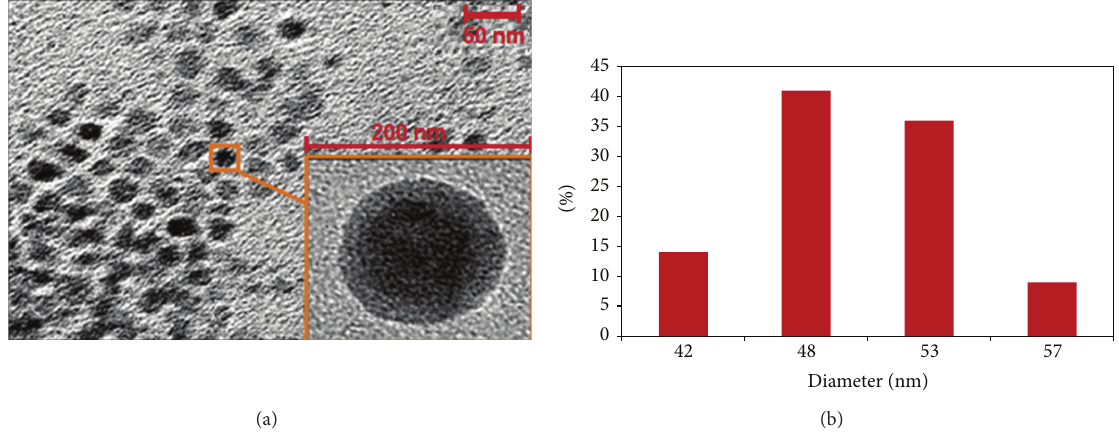
Figure 1: (a) TEM images of freshly prepared BCP; inset is TEM image of an individual Cu/Mg on BCP. (b) Size distribution of BCP.